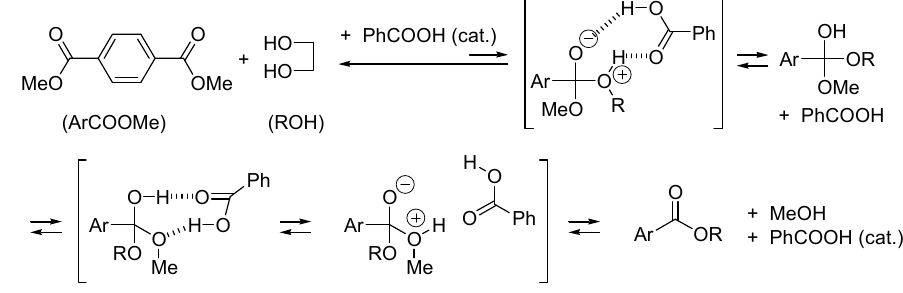
Figure 4. Limiting mechanisms for an acyl transfer reaction that are neither catalyzed, nor assisted by solvent (x ‐ axis describes distance CO ∙∙∙ X, y ‐ axis distance Nu ∙∙∙ C=O and the free energy is perpendicular to the plane).